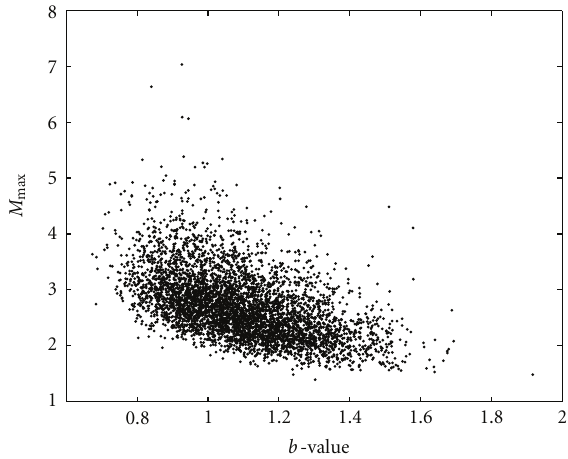
Figure 2: Model relationship between the b -value and maximal magnitude M max value occurred in the next time